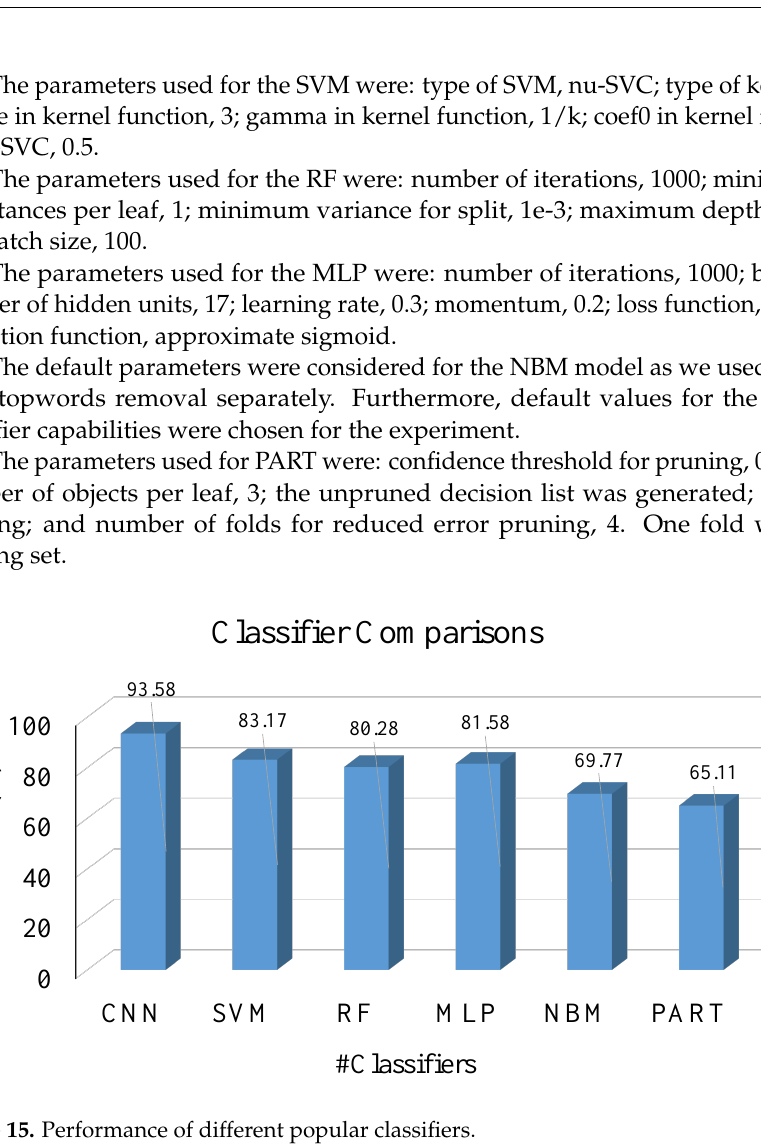
Figure 15. Performance of different popular classifiers.